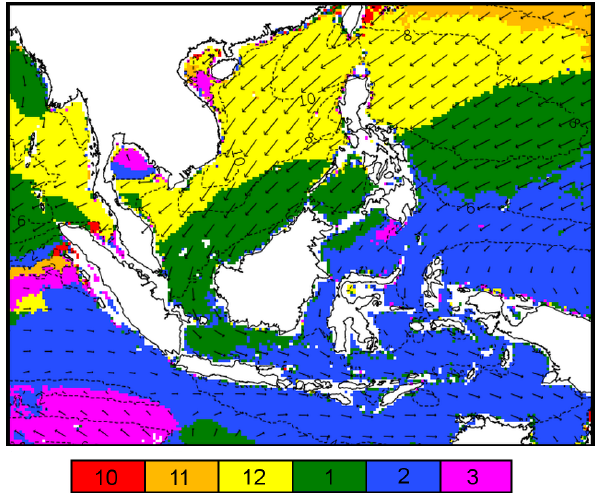
Figure 1. Basis wind for fracsign calculation. Dotted contours show the wind magnitude while arrows indicate direction. Colours show the month when the maximum wind magnitude occurs.